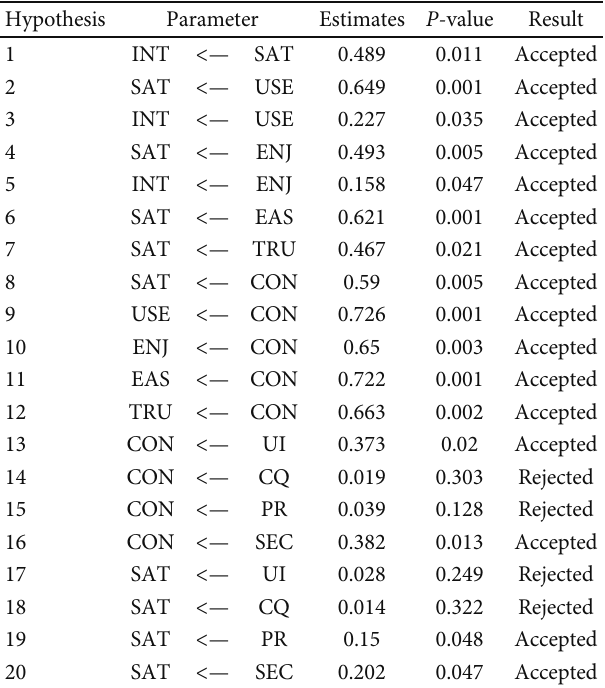
Table 7: Hypothesis test